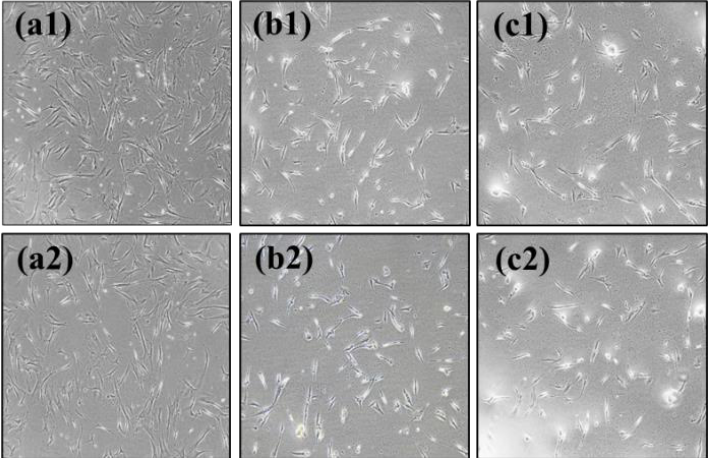
( b ) Figure 5. Expression of neuron-related proteins and genes in human umbilical-cord-derived mesenchymal stem cells after recombinant PLXNA4 protein treatment. Cells were harvested 5 days after 2 μ g/mL recombinant PLXNA4 protein treatment. ( a ) Fluorescence images of each protein. Original magnification 200×. ( b ) Fold expression of each gene using real-time polymerase chain reaction analysis. MAP2: Microtubule-associated protein 2. NEUROD1: Neuronal Differentiation 1, NF-L: Neurofilament-L, MBP: Myelin basic protein, Column heights correspond to mean values and error bars to standard deviations ( n = 3). * p < 0.05, ** p < 0.01 .